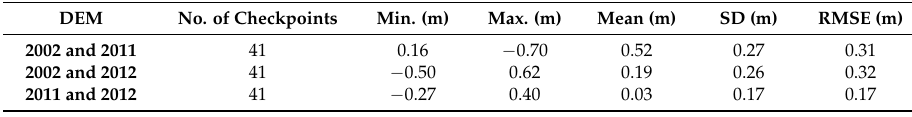
Table 5. Elevation error estimations between every two periods of ALS DEMs using the same ground control points.